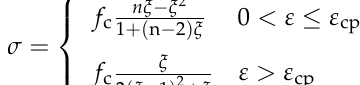
Figure 7. Constitutive relationship of the normal concrete.